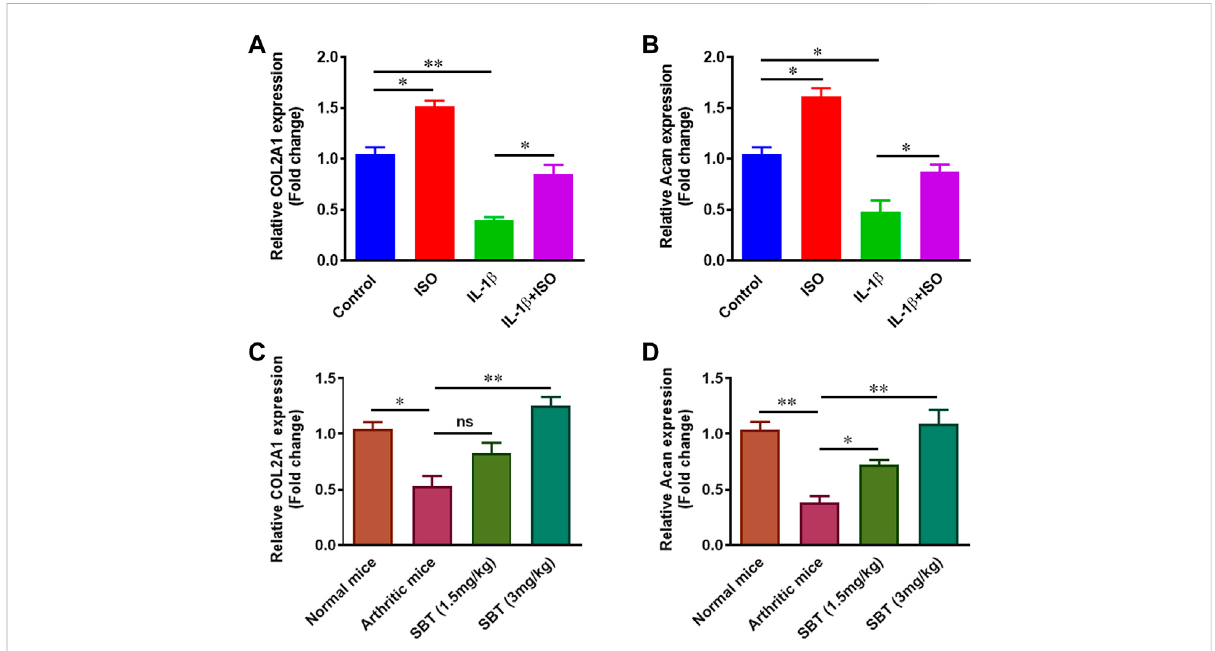
FIGURE 9 Gene expression analysis of proteoglycans in vitro and in vivo . CHON-001 cells were treated with ISO (10 − 5 mol/L), IL-1 β (10 ng/ml) or combination of both for 24 h. Gene expression analysis of COL2A1 (A) and Acan (B) was measured by using qPCR technique. Relative gene expression analysis of COL2A1 (C) and Acan (D) in murine chondrocytes by using qPCR. All the experiments were performed in duplicate manner. Data were analyzed by Graph-Pad prism version 7.0. Signi fi cance of data was measured by using One Way ANOVA with Boneferroni ’ s multiple comparison test. * p < 0.05, ** p < 0.01, ns, not signi fi